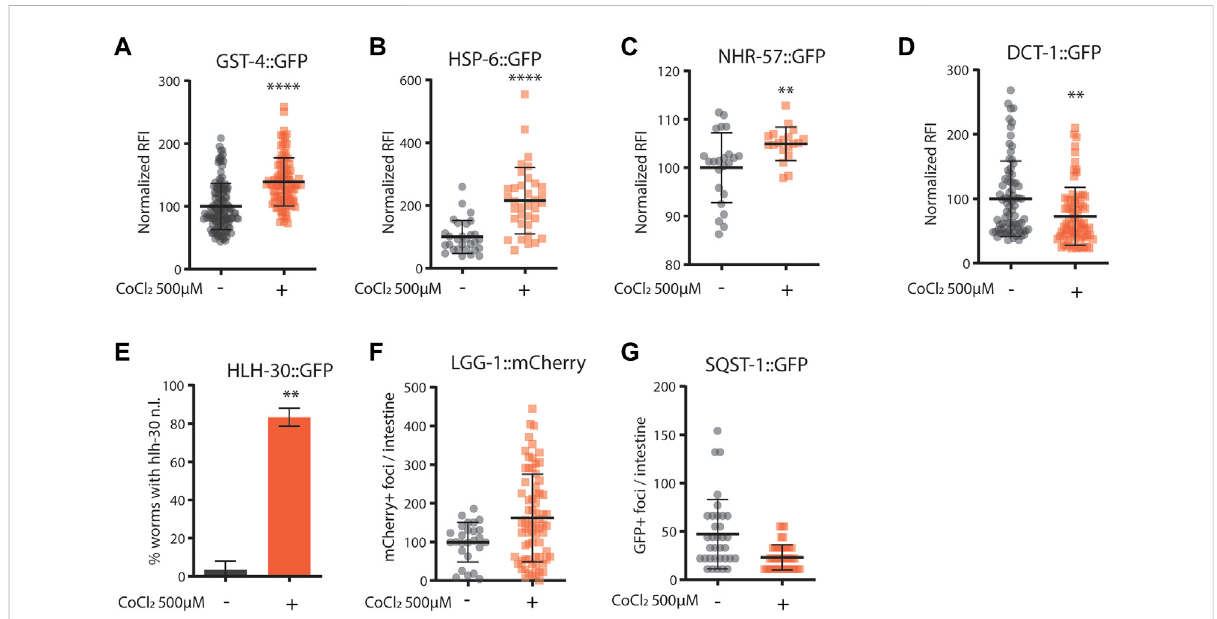
FIGURE 3 (A – G) Quanti fi cation of fl uorescencereported strainsinadultworms(4days old)leftuntreated( − )ortreatedfromeggs withCoCl 2 500 µM (+). Relative fl uorescence intensity normalized to animals ’ size was quanti fi edin GST-4::GFP (A) , HSP-6::GFP (B) , NHR-57::GFP (C) , and DCT-1::GFP (D) . Percentage of worms with HLH-30::GFP nuclear localization (E) . Fluorescence foci number was quanti fi ed in LGG-1: mCherry (F) and SQST-1::GFP (G) .Bargraphrepresentsmeans±SD( n =3,N=10 – 15);linesinthescatterplotsrepresentmeans±SD( n =3,N=10 – 15).Comparisonbetween con and CoCl 2 was performed using the unpaired t-test. ** p value < 0.01 and **** p value < 0.0001, versus con.